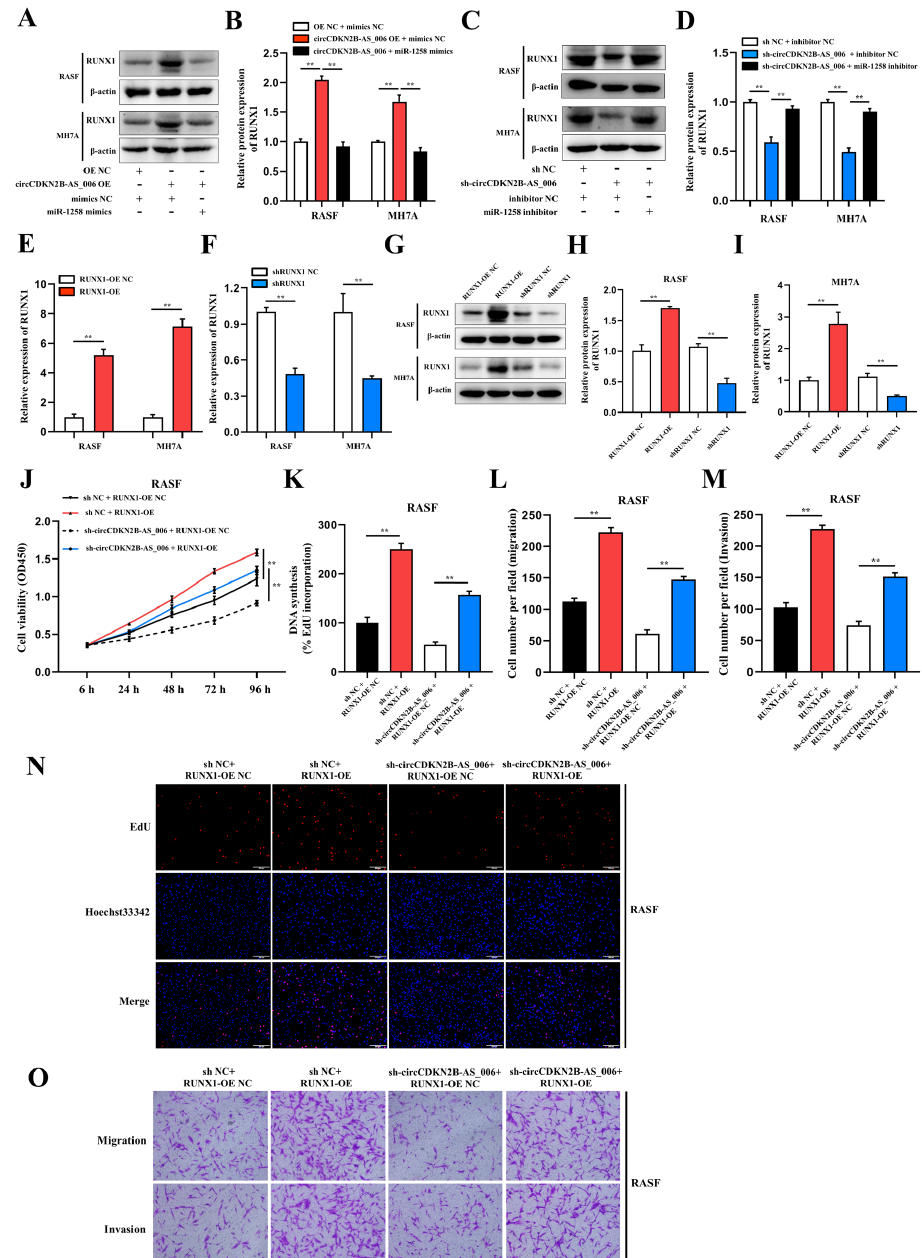
Figure 6. CircCDKN2B − AS_006 promotes RASF proliferation, migration, and invasion via the miR−1258/RUNX1 axis. ( A , B ) RUNX1 expression was analyzed in RASFs and MH7A cells after transfection with circCDKN2B−AS_006 overexpression and miR−1258 mimics. ( C , D ) RUNX1 expression was analyzed in RASFs and MH7A cells after transfection with circCDKN2B−AS_006 knockdown and miR−1258 inhibitors. ( E , F ) The efficiency of RUNX1 overexpression ( E ) and silencing ( F ) in RASFs and MH7A cells was verified by means of RT−qPCR. ( G – I ) The efficiency of RUNX1 overexpression ( G , H ) and silencing ( G , I ) in RASFs and MH7A cells was verified by means of Western blot analysis. ( J , K , N ) The cell proliferation levels were determined after transfection with sh − circCDKN2B − AS_006 and RUNX1 overexpression by means of the CCK − 8 ( J ) and EdU assays ( K , N ). ( L , M , O ) After transfection with sh − circCDKN2B − AS_006 and RUNX1 overexpression, the cell migration and invasion were determined by transwell assay. ** p <